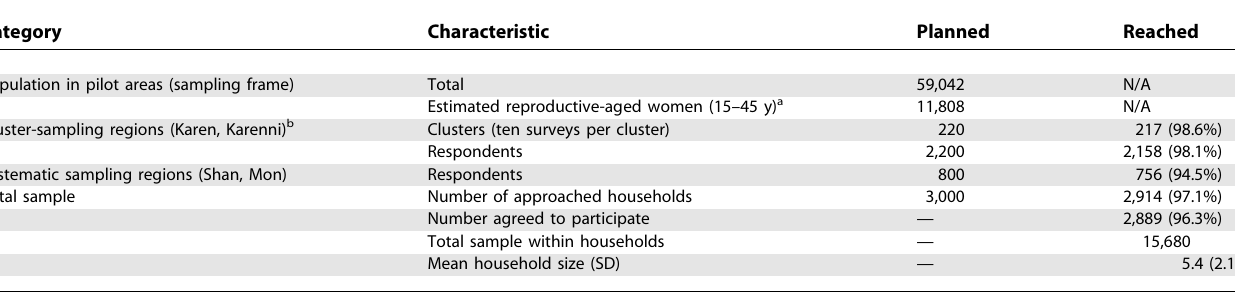
Table 1. Survey Sample and Basic Demographic Characteristics of Participating